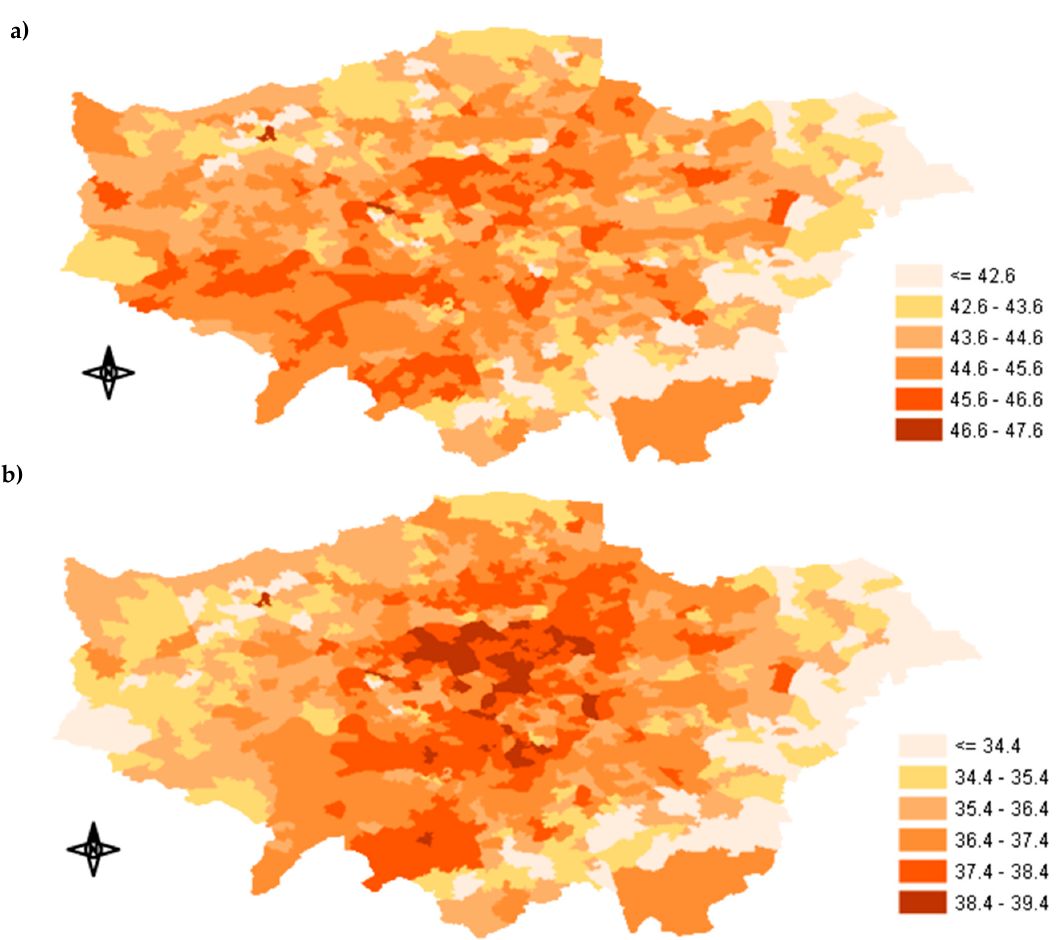
Figure A2. Percentage (%) of exposure concentration reduction between Tier 1 and: ( a ) Tier 3 and ( b ) Tier 4.